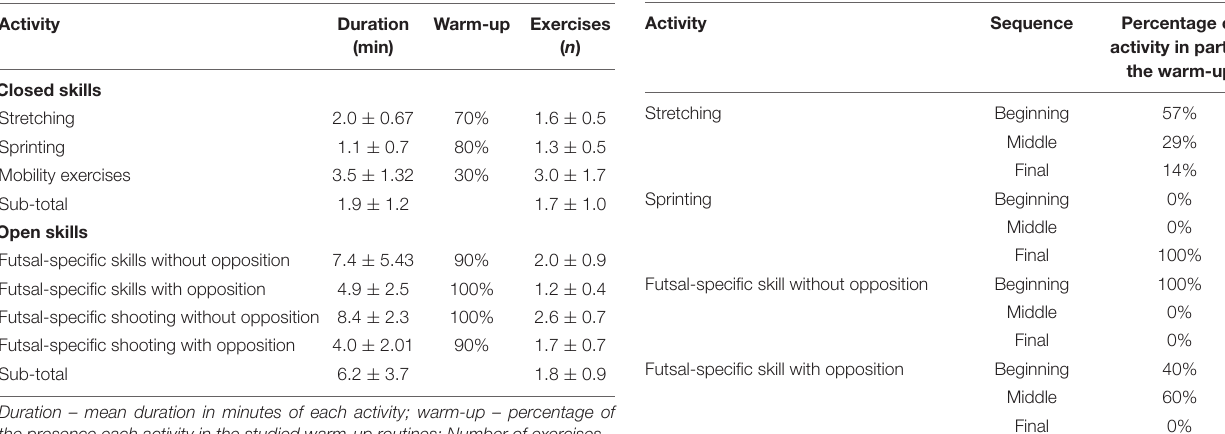
TABLE 2 | Sequence and percentage of activities occurred at the beginning, middle, or final phase of the